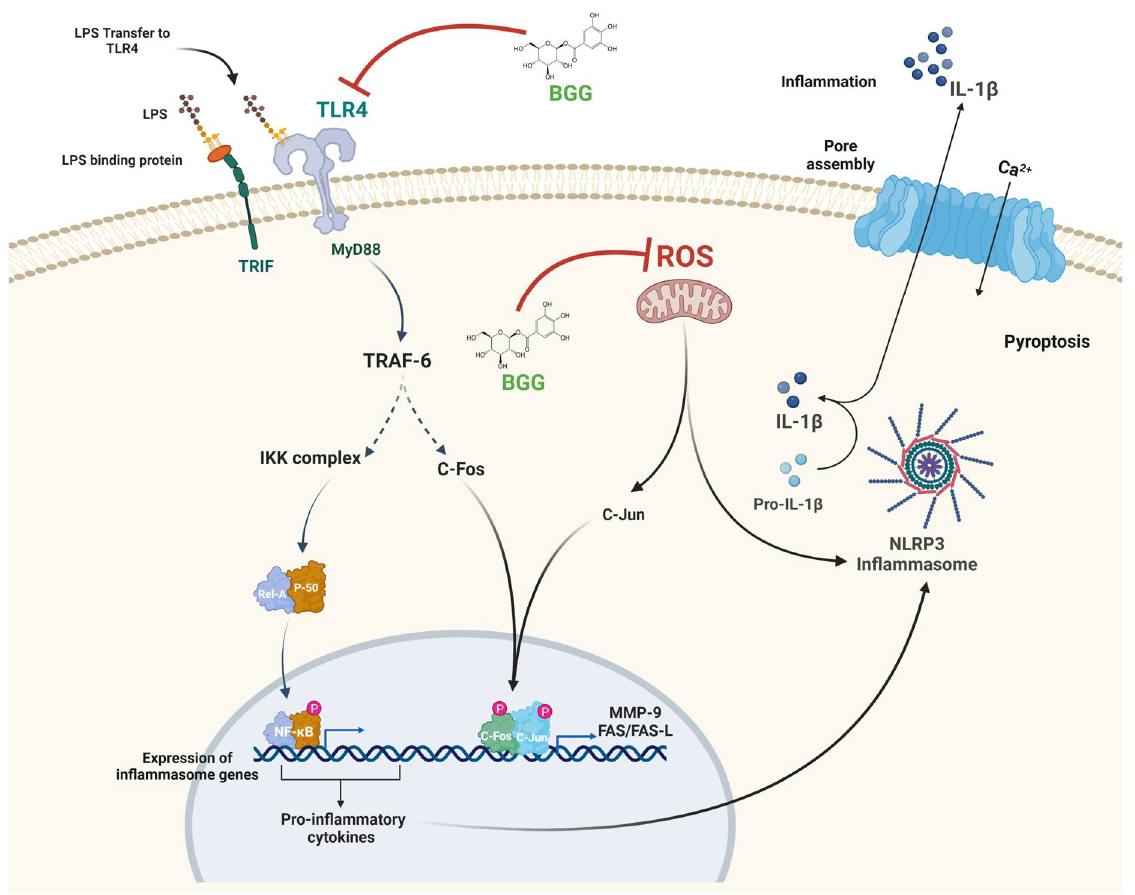
Figure 19. Represents the predicted protective pathway of BGG for blocking LPS